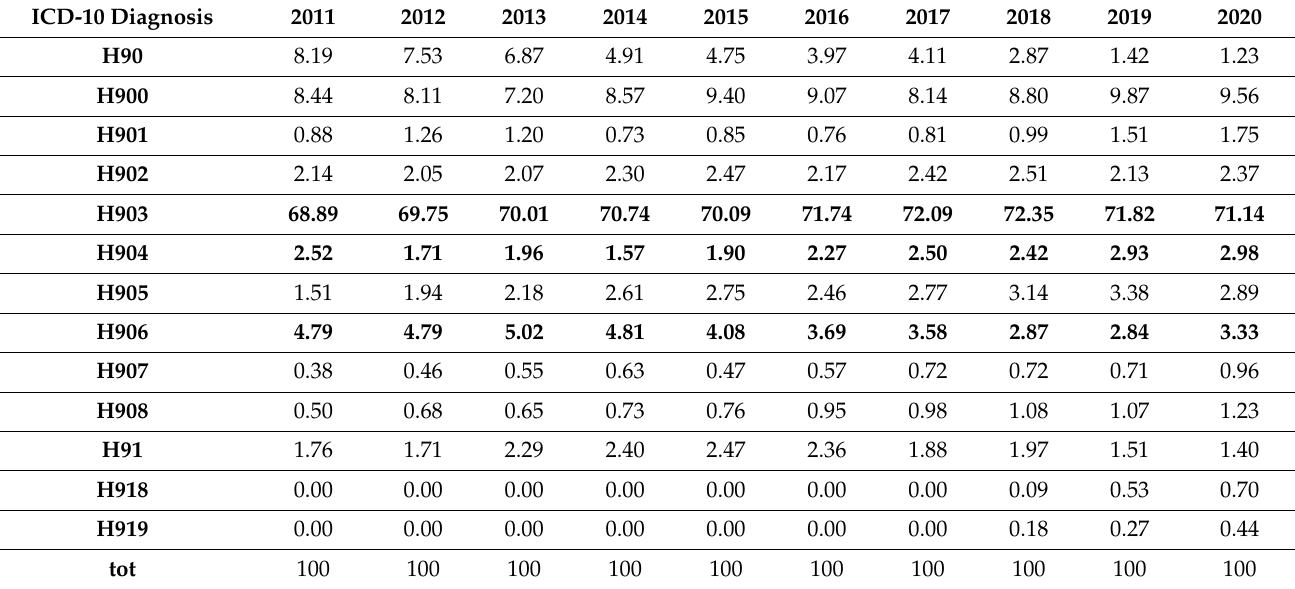
Figure 3. New diagnosis at CAMHS (codes H90–H91) per year. Table 3. Subjects (in percentage) affected by hearing loss, subdivided according IC10 classification into further H90 subtypes. ICD-10